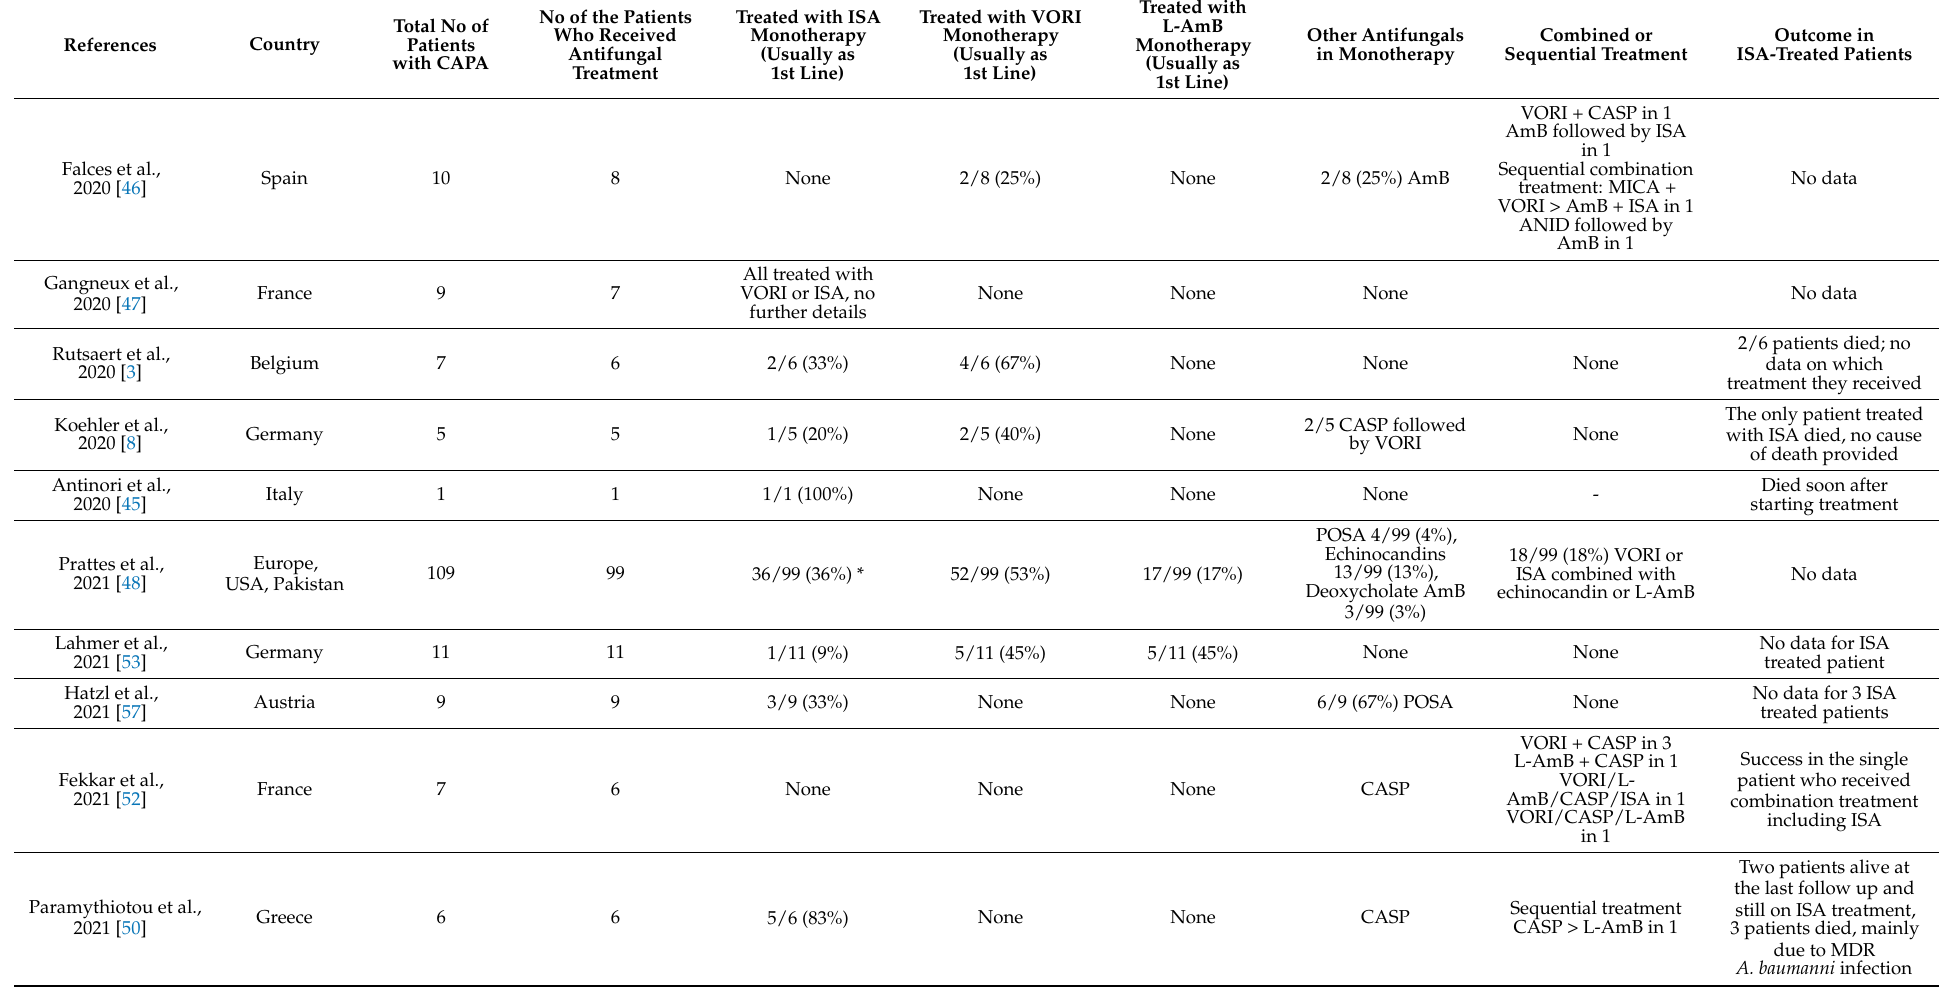
Table 2. Fourteen studies which reported patients with CAPA in whom isavuconazole treatment was